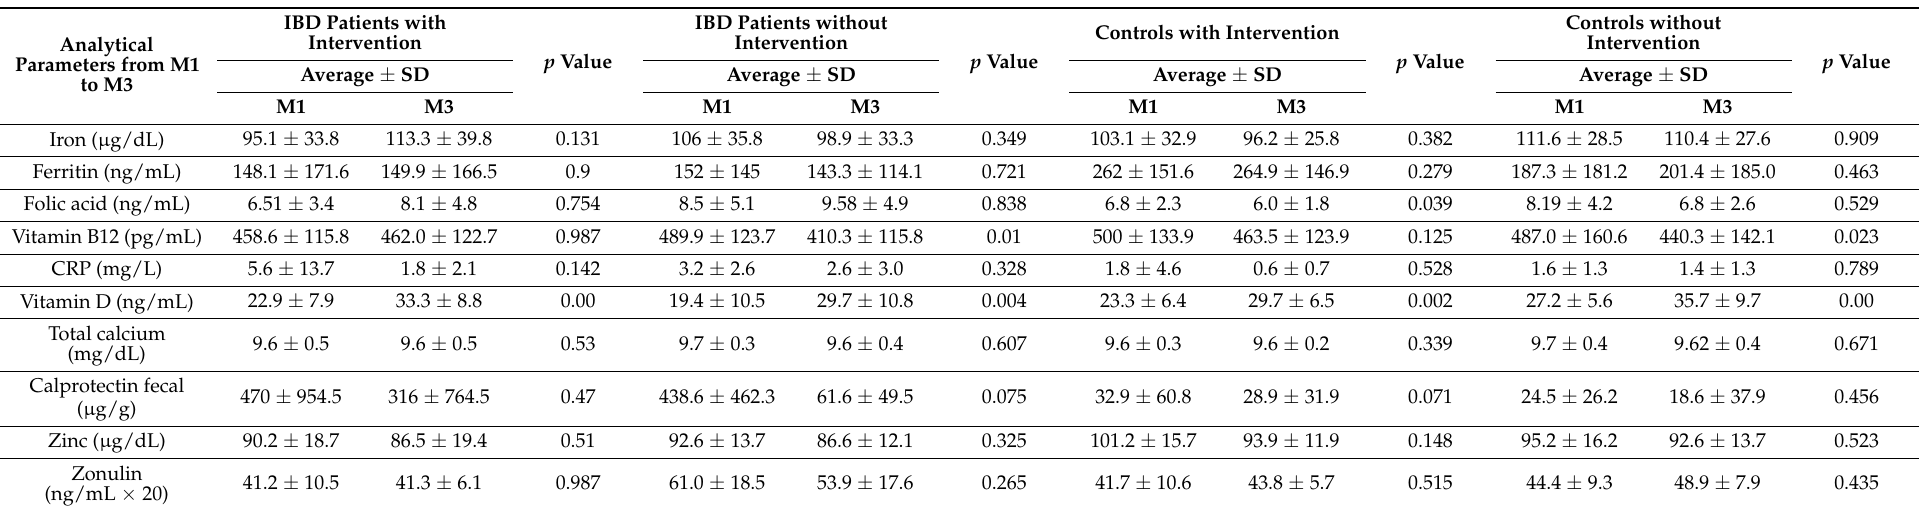
Table 5. Analytical parameters comparison from M1 to M3 of different